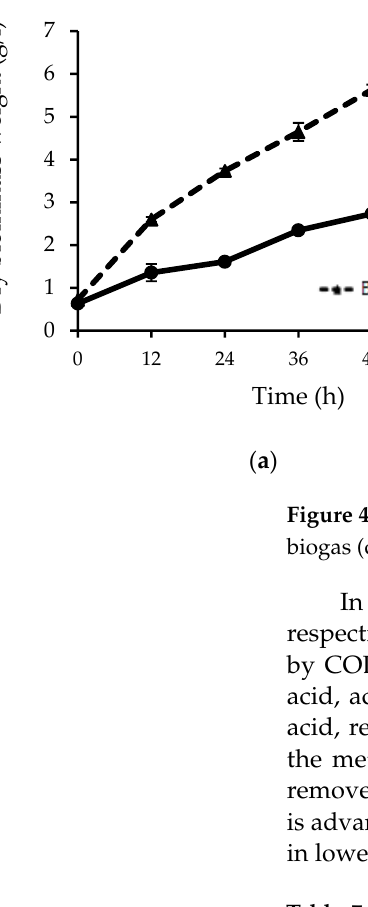
Table 7. Production of the desirable and undesirable products during fermentation with CO 2 supplement in a form of pure gas or